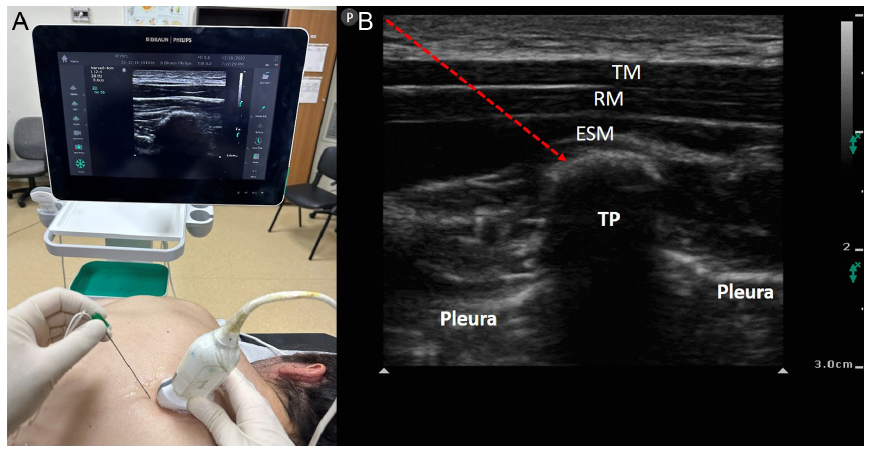
Figure 2. A, B. (A) Patient and ultrasound probe position for thoracic erector spinae plane block procedure. (B) Sonographic anatomy of the block. ESM, erector spinae muscle; RM, rhomboid muscle; TM, trapezius muscle; TP, transverse process; red arrow,